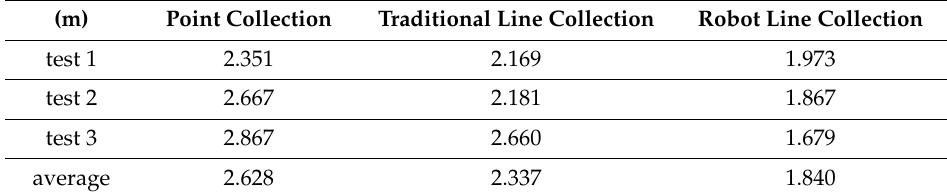
Table 2. Positioning RMSE of three dynamic tests.